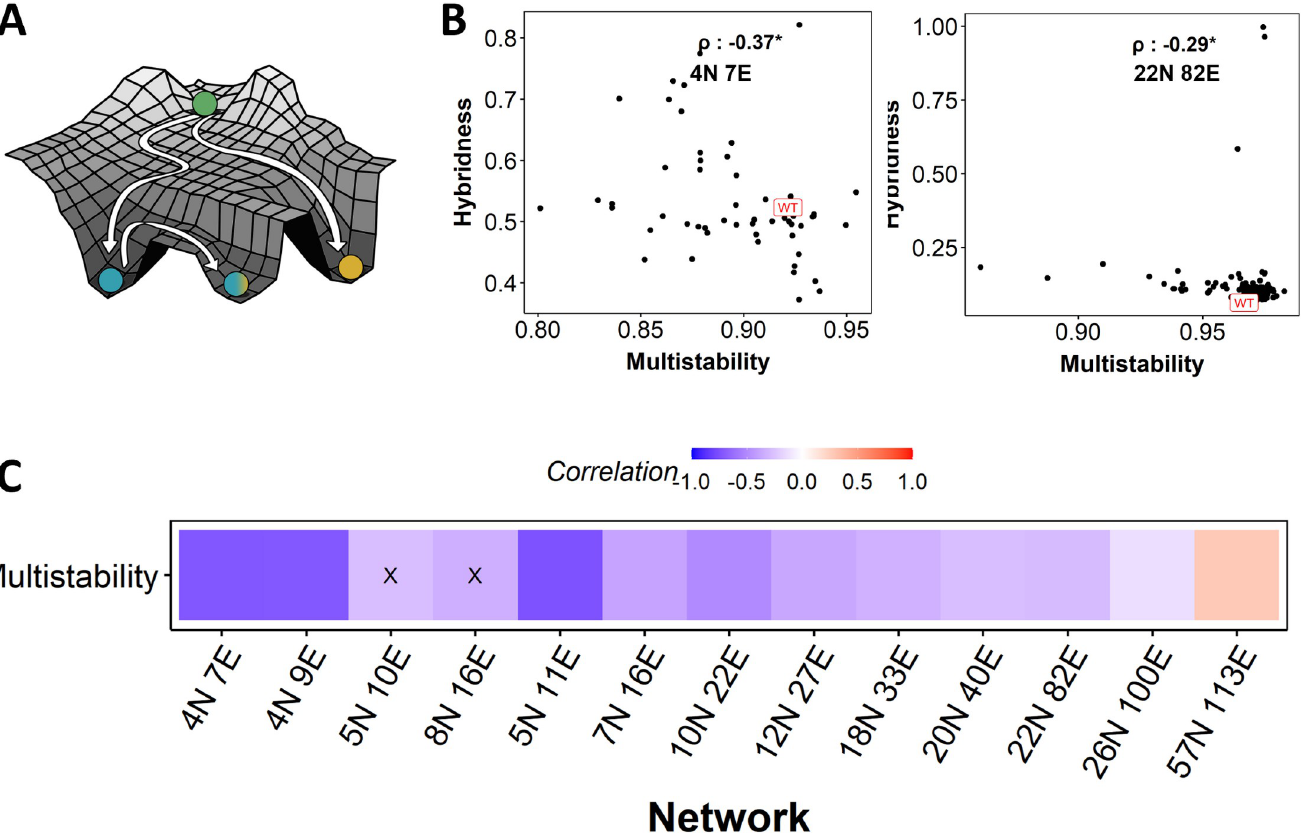
Fig 3. Increase in hybridness leads to reduced multistability. (A) Depiction of multistability, where valleys represent the steady states/phenotypes that the system (EMP network) can sample. (B) Representative scatter plots between multistability and hybridness. Spearman correlation coefficient is reported. (C) Heat map showing Spearman correlation coefficient values between hybridness and multistability across EMP networks. “X” represents p-value > 0.05.